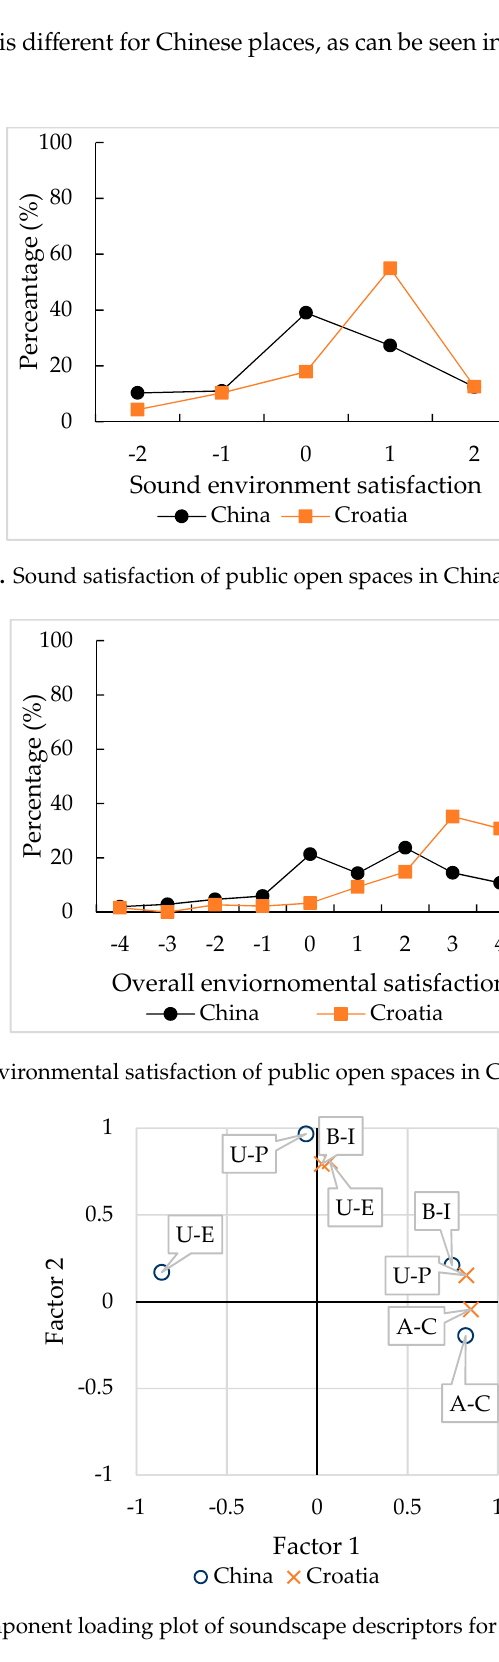
Figure 3. Component loading plot of soundscape descriptors for China and Croatia. Relationships among subjective satisfaction, tranquility importance and soundscape descriptors are shown in Table 3. It can be seen that sound satisfaction is positively correlated with environmental satisfaction both in China ( p < 0.01) and in Croatia ( p < 0.01). The importance of tranquility in public open spaces is negatively correlated with sound environment evaluation in China ( p < 0.05) and in Croatia ( p < 0.01), which means that the higher the requirement for environmental tranquility, the